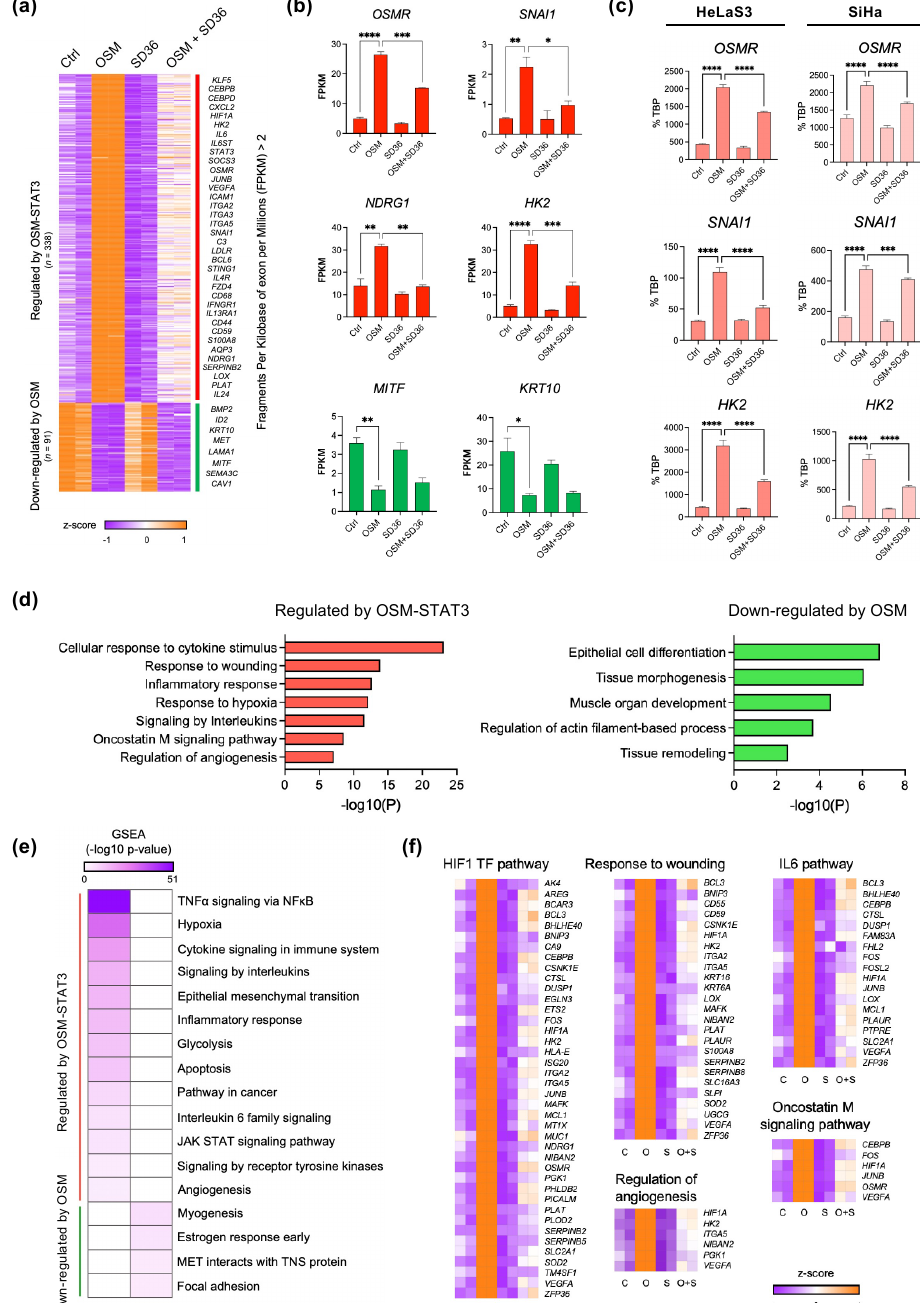
Figure 4. Regulation of OSM-induced transcriptome by STAT3 in cervical cancer. ( a ) Two clusters of 429 differentially expressed genes in pairwise comparisons between the four conditions; log2FC > 1; adj. p < 0.05; FPKM > 2. ( b ) Examples of expression of selected genes in the two clusters identified in Figure 3C. ( c ) Relative expression was normalized to internal control (TBP) and expressed relative to untreated, OSM-treated, and OSM + SD-36 treated HeLaS3 and SiHa; * p < 0.05, ** p < 0.01, *** p < 0.001, **** p < 0.0001; Ordinary one-way ANOVA. ( d ) GO analysis of DEGs in cluster “ Regulated by OSM-STAT3 ” and “ Down regulated by OSM ”. ( e ) Heatmap showing the p -value significance of GSEA (gene sets of Hallmarks, KEGG, and Reactome) for two clusters. ( f ) Heatmap and GO term enrichment for 91